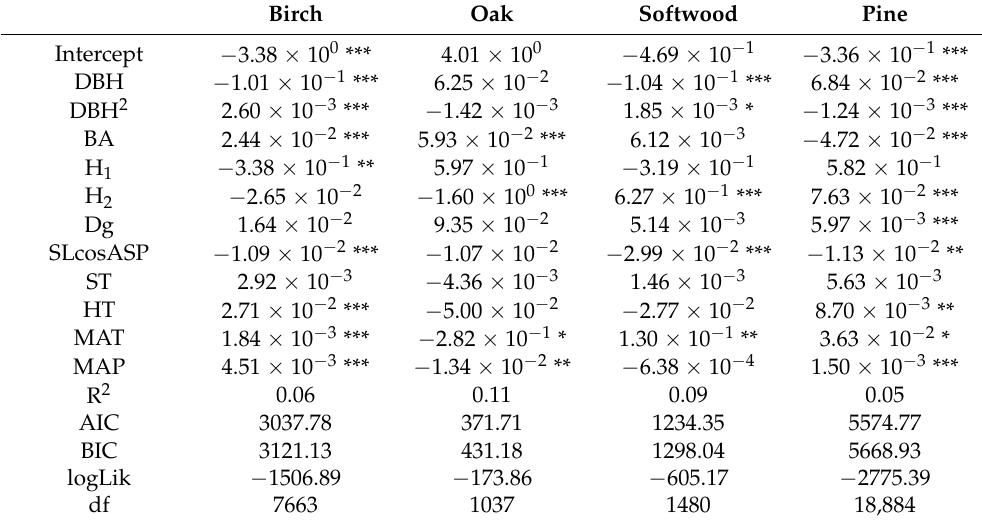
Table 6. The estimated parameters with the lack-of-fit statistics for mortality equations. If a tree died between the two inventories, the dependent variable, mortality, equals one if a tree died between the two inventories, if not, it equals